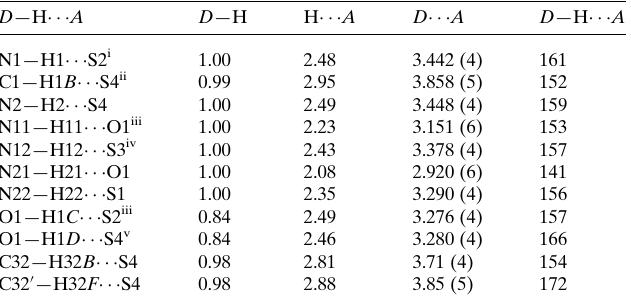
Table 2 Hydrogen-bond geometry (A˚ , (cid:5)